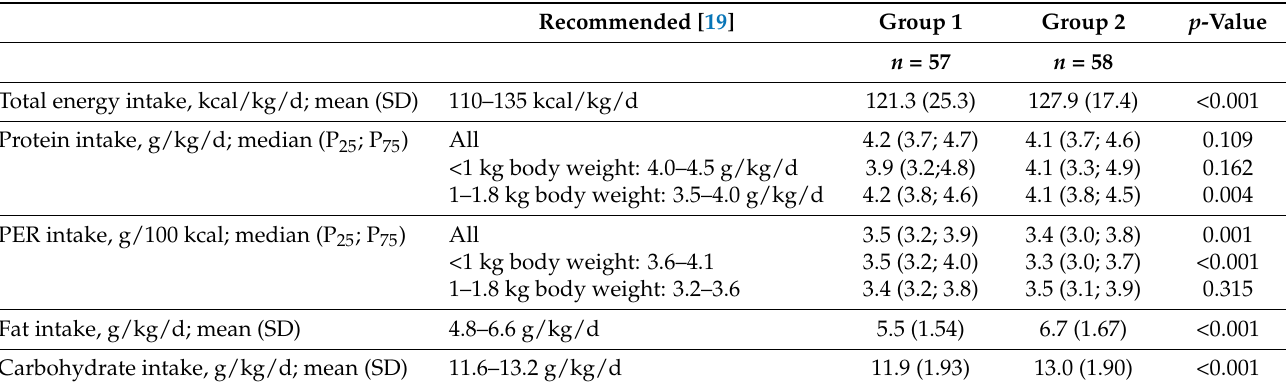
Table 3. Energy and macronutrient intake in infants completing the study exposure period ( n = 115). Group 1—fortified HM based on its assumed macronutrient content. Group 2—fortified HM based on its measured macronutrient